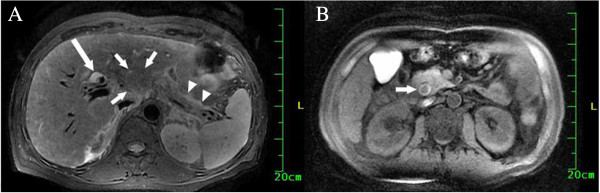
Magnetic resonance imaging findings on 21 September 2011. (A) Short inversion time inversion recovery image, showing an irregular, isointense mass with unclear margins (short white arrows) in the left lobe of the liver. There was fluid around the pancreas (white arrows) indicating pancreatitis, and mild dilation of the intrahepatic bile ducts (long white arrow). (B) Short inversion time inversion recovery image distal to the plane of image (A), showing a dilated common bile duct with an isointense filling defect (white arrow).